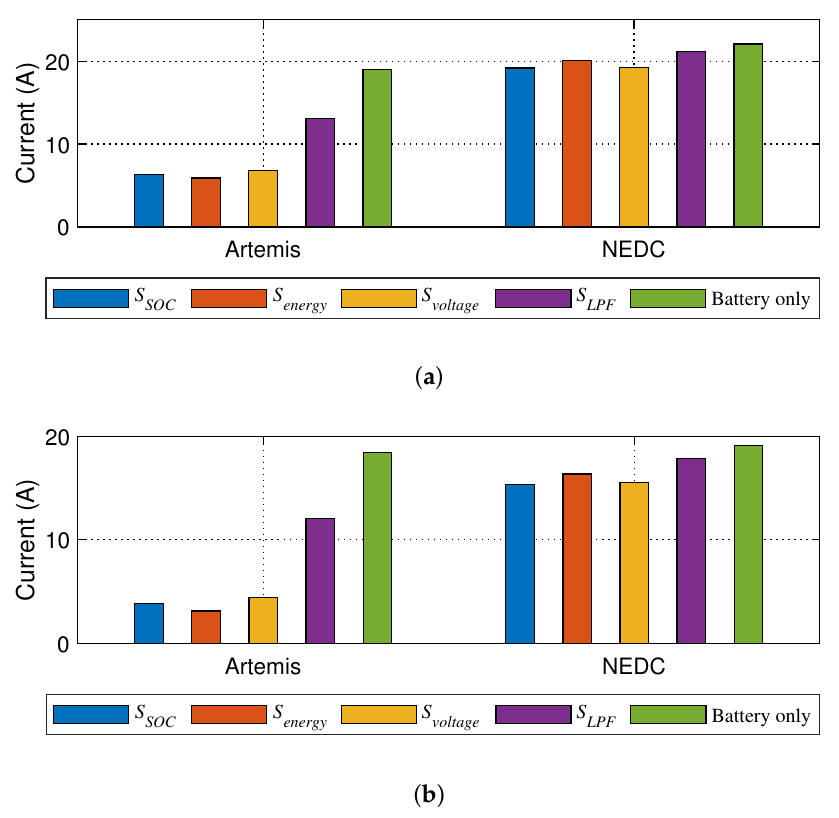
Figure 13. Performance of the studied EMS for the battery/SC EV from the simulations: ( a ) Root mean squared currents of the battery; ( b ) Standard deviation of the battery